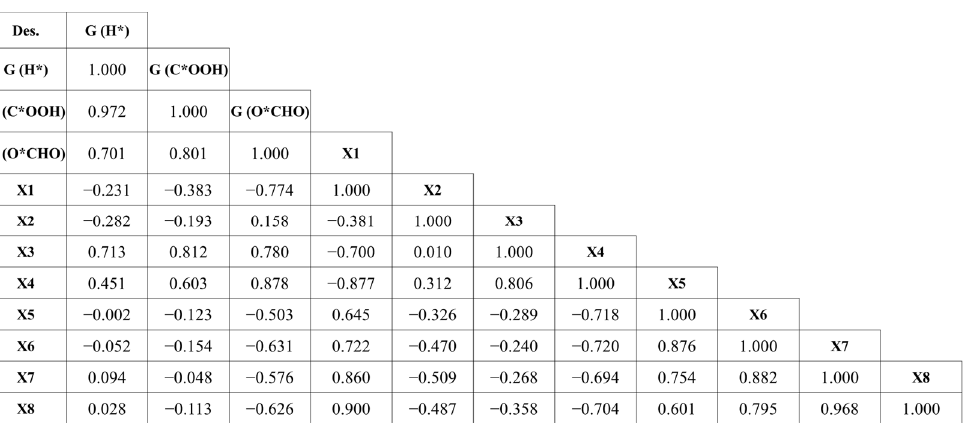
Figure 3. The optimized structure of the transition-metal–porphyrin complexes and the definitions of the structural and electronic properties (TM–PPs, TM = Sc, Ti, V, Cr, Mn, Fe, Co, Ni, Cu, and Zn). The white, gray, blue, and pink colors represent H, C, N, and TM atoms, respectively. Figure 4. Pearson correlation coefficients between the three Gibbs free energies and the eight prop- erties obtained from DFT of the TM–PP complexes.